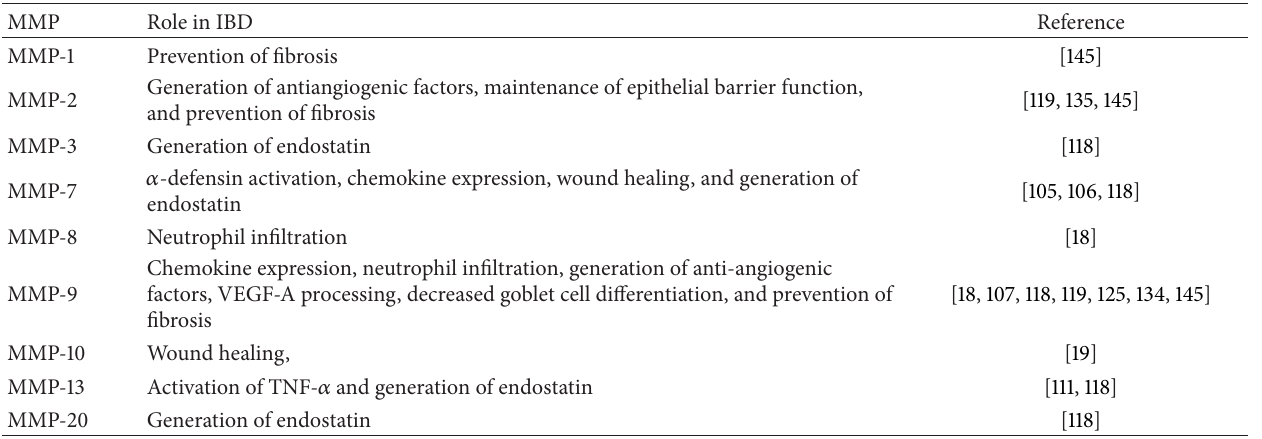
Table 1: Recently described roles for MMPs in